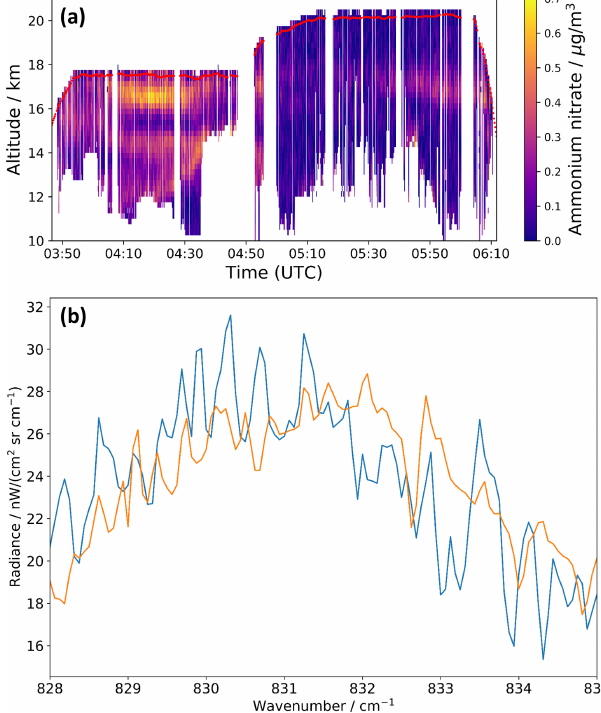
Figure 6. (a) AN mass concentrations retrieved from GLORIA measurements during the StratoClim research flight on 31 July 2017 using the n( ˜ ν x ) = 1 . 56, χ = 1 . 1, and ϕ = 1 refractive index data set (see Fig. 3b in Höpfner et al., 2019, as a comparison). Red line: aircraft altitude. (b) Difference of mean GLORIA spectra be- tween 04:15–04:21 and 04:35–04:43UTC at 16.5–16.75km alti- tude (blue) and best spectral fit with the AN optical constants (or- ) ange) in the range of the ν 2 ( NO − 3